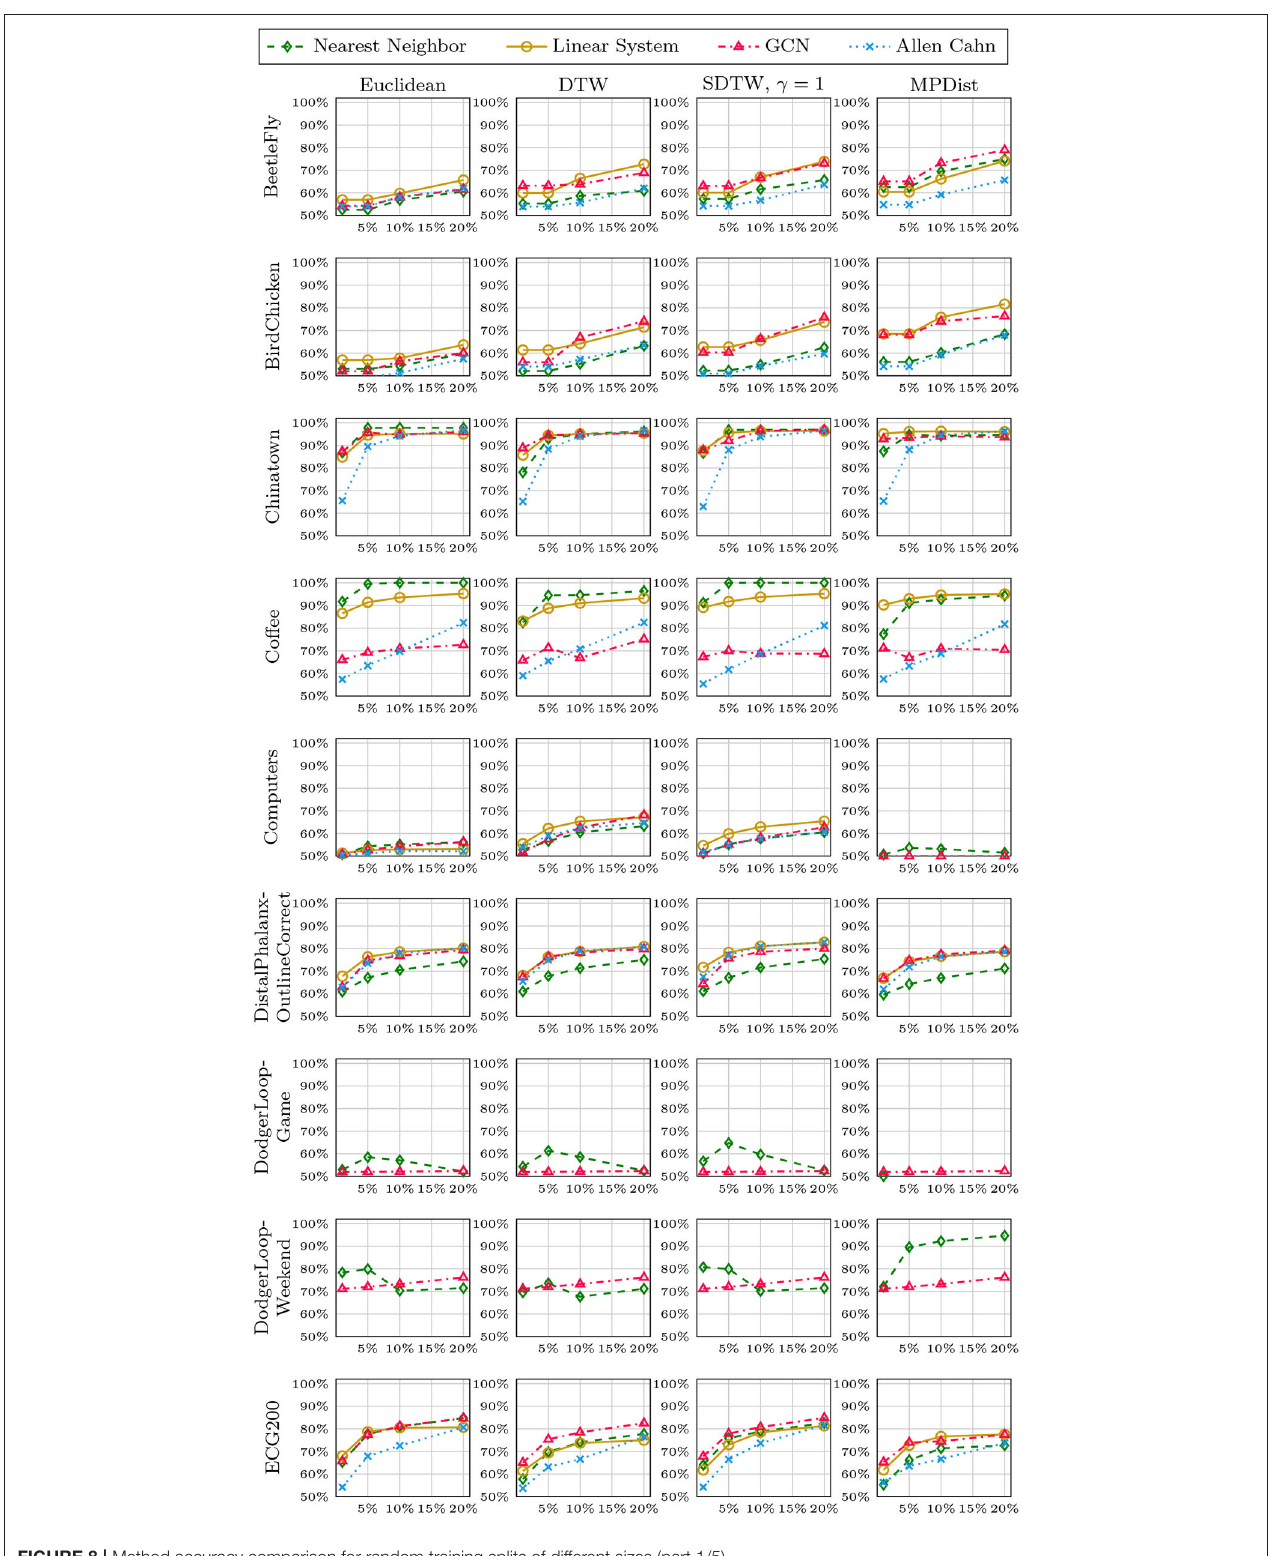
FIGURE 8 | Method accuracy comparison for random training splits of different sizes (part